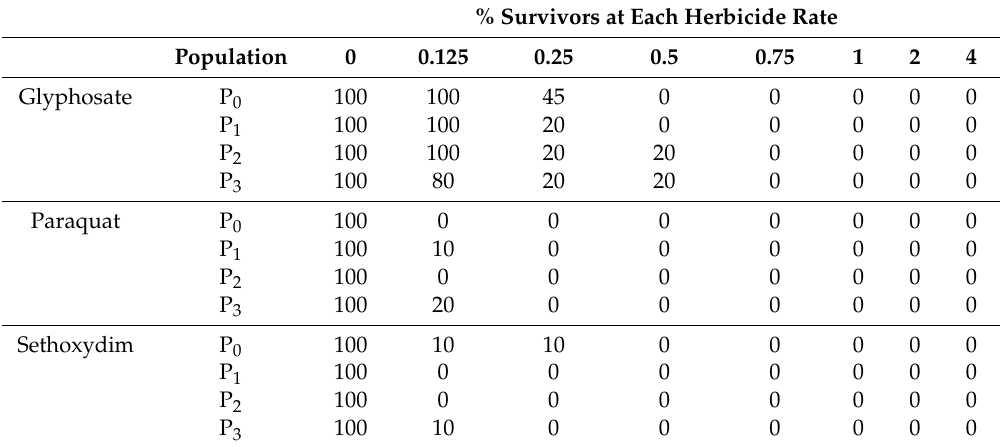
Table 3. Percentage of plants from the parental population (P 0 ) and three generations of progeny (P 1 –P 3 ) that survived treatment with glyphosate, paraquat, and sethoxydim 21 DAT a